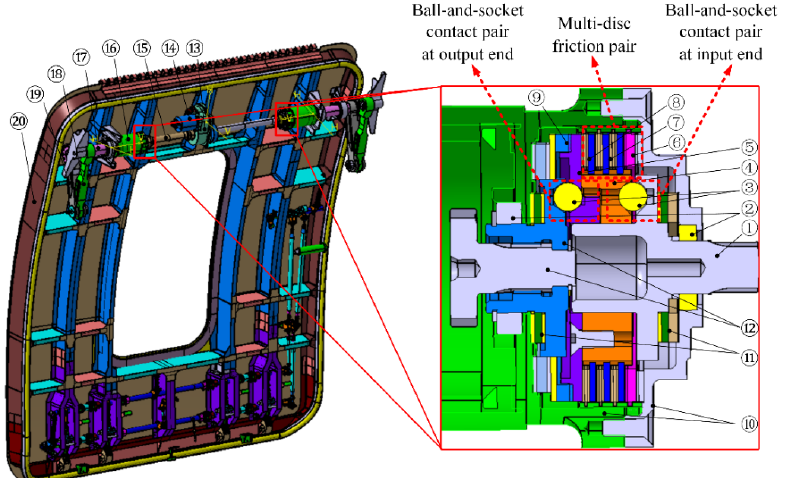
Figure 2. Rear left hatch door of through cabin and non ‐ return mechanism: ① Input shaft, ② Support bearing, ③ Steel ball, ④ Small connecting shaft, ⑤ Big connecting shaft, ⑥ Pressure plate, ⑦ Steel disc, ⑧ Friction disc, ⑨ Wave spring, ⑩ Housing, ⑪ Thrust bearing, ⑫ Output Shaft, ⑬ Main Reducer, ⑭ Motor, ⑮ Transmission shaft 1, ⑯ Planetary reducer, ⑰ Transmission shaft 2, ⑱ Rocker arm, ⑲ Link lever, ⑳ Door.